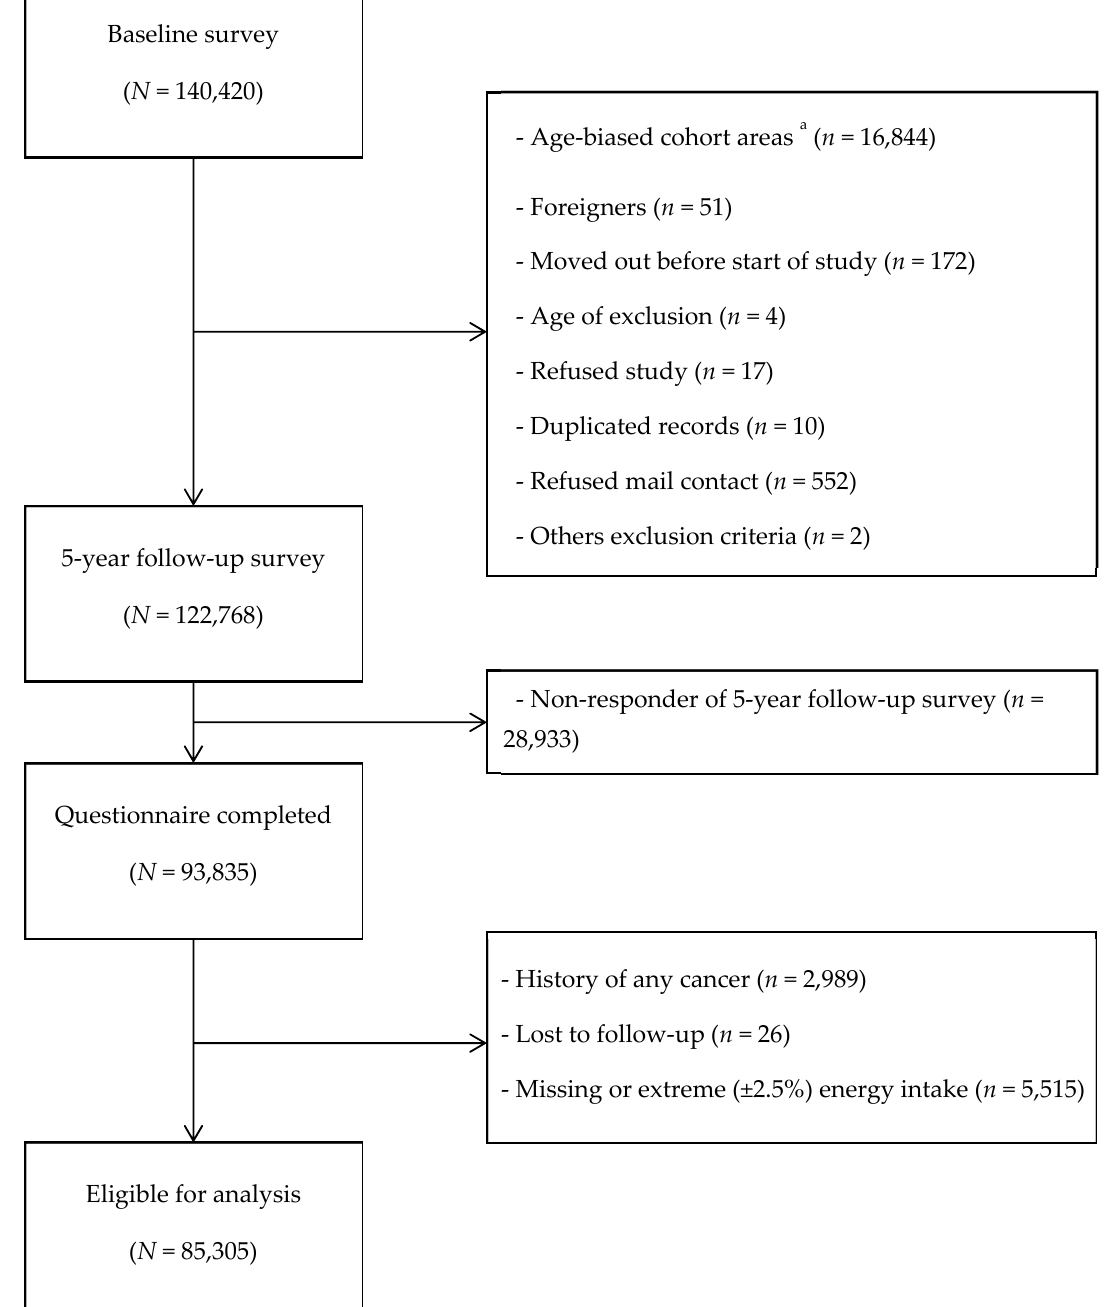
Figure 1. Flow diagram of eligibility for analysis. a Participants only at the age of 40 yrs. And 50 yrs. old received baseline questionnaire in these areas.